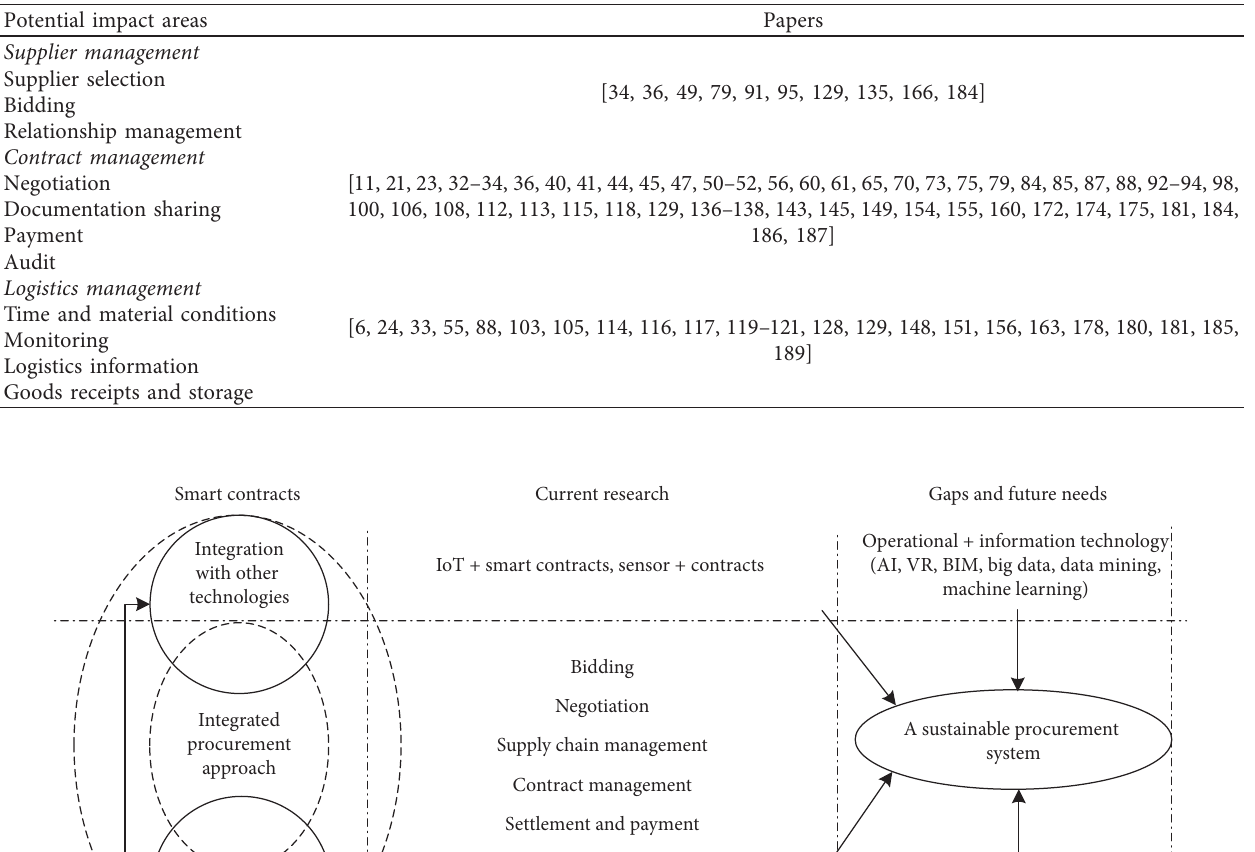
Table 7: Potential advantages of smart contracts in the procurement process.